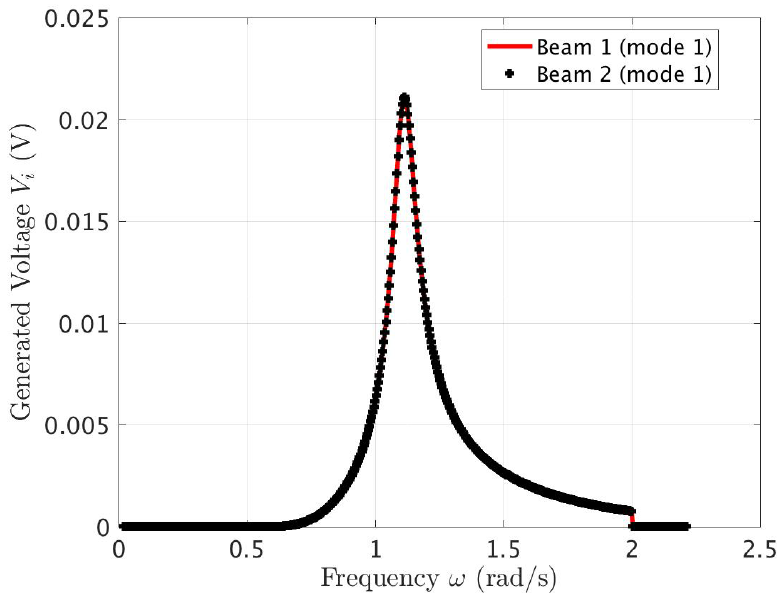
Figure 7. Voltage produced by Galfenol strips on each beam in response to an irregular wave spectrum (Pierson–Moskowitz, H s = 1.0 m, T e = 5.0 s). Beams fit the deck support tightly.